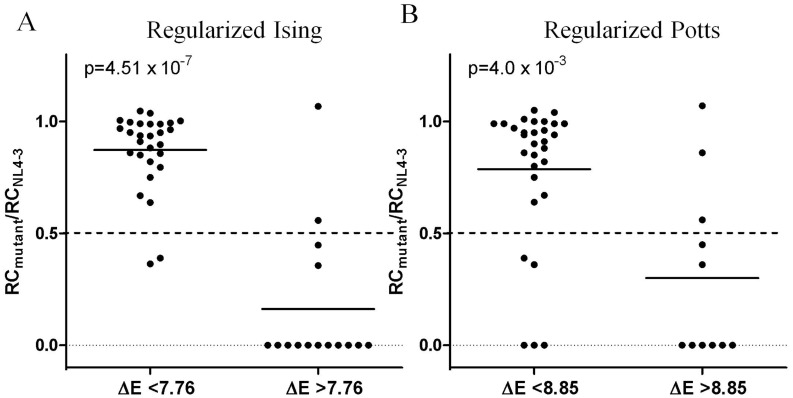
Classification of HIV-1 NL4-3 Gag mutants as unfit/fit using predicted E values.Graphs show the ability of E classifiers, predicted by regularized Ising (panel A) and Potts (panel B) models, to correctly classify HIV-1 NL4-3 Gag mutants into unfit (RC<0.5) and fit (RC>0.5) categories. The measured replication capacities of mutants classified as fit or unfit according to their predicted E values were compared with the Mann-Whitney test and p values are shown.